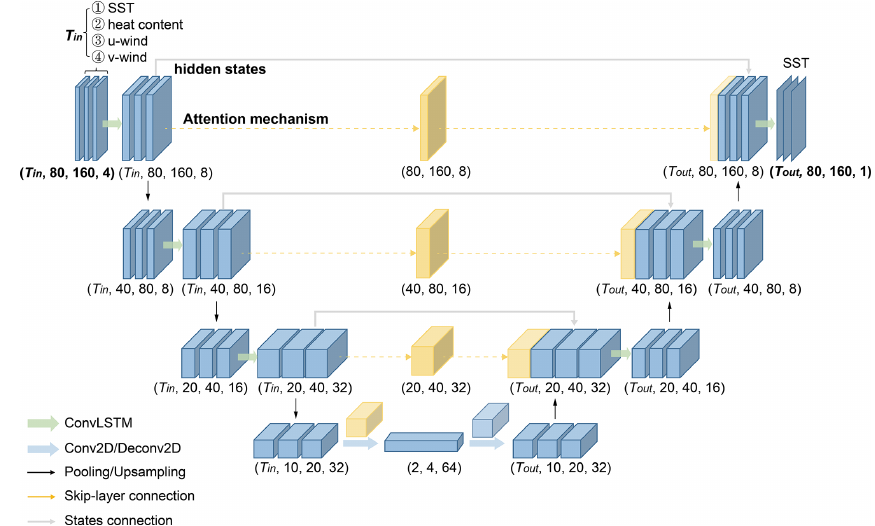
Figure 1. The encoder–decoder architecture of ENSO-MC for SST pattern sequence prediction. The encoder contains three ConvLSTM layers and each layer is followed by a pooling layer, and the last layer is a convolutional layer, which allows extracting spatial and temporal features. The decoder comprises one deconvolutional layer, three ConvLSTM layers and three upsampling layers that restore the features to the same size as the initial spatial dimensions (80 × 160). The model uses a skip-layer connection with an attention mechanism and a states connection between the encoder and the decoder to improve forecasting skills. The input variables are the SST, heat content, zonal wind and meridional wind for T in consecutive months over 40 ◦ N–40 ◦ S, 120 ◦ E–80 ◦ W (80 × 160, 1 ◦ × 1 ◦ resolution), and each type of variable is input to the model as a channel. The output of the model is an SST pattern sequence for the next T out months.